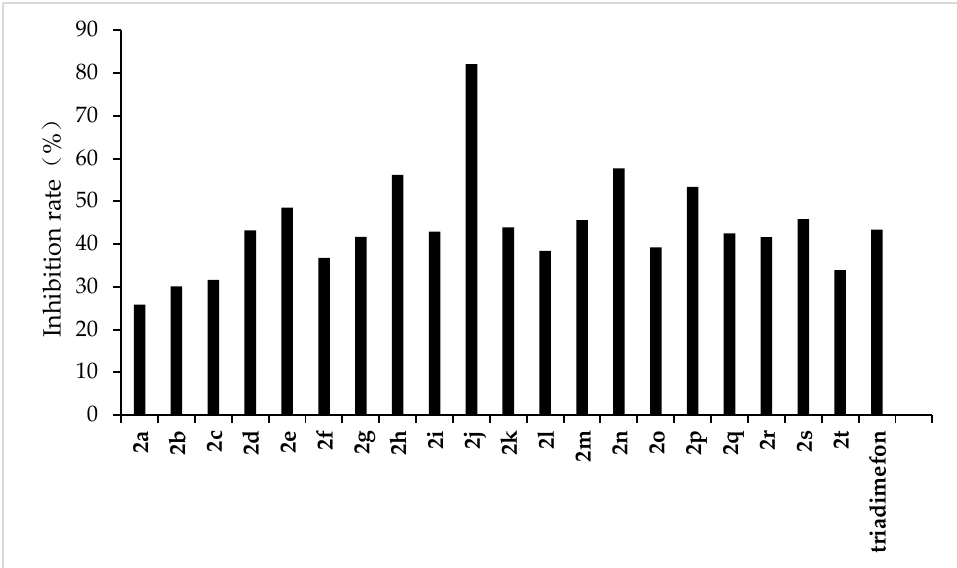
Figure 7. Antifungal activity of the synthesized compounds ( 2a ‒ 2t ) against P.p. var. nicotianae.